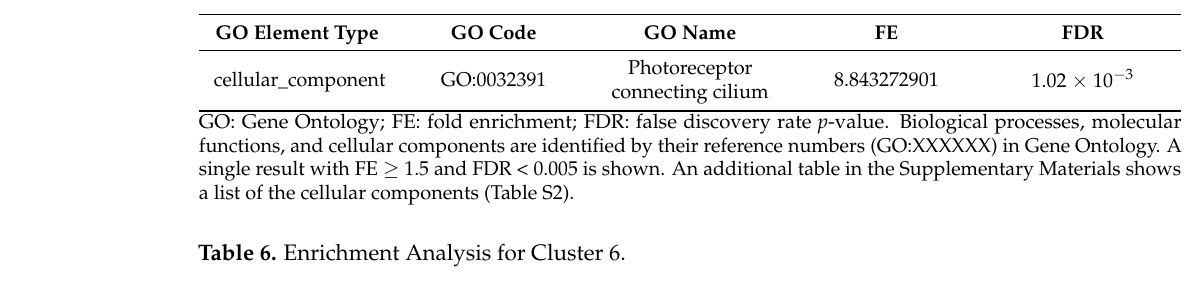
Table 5. Enrichment Analysis for Cluster 3.